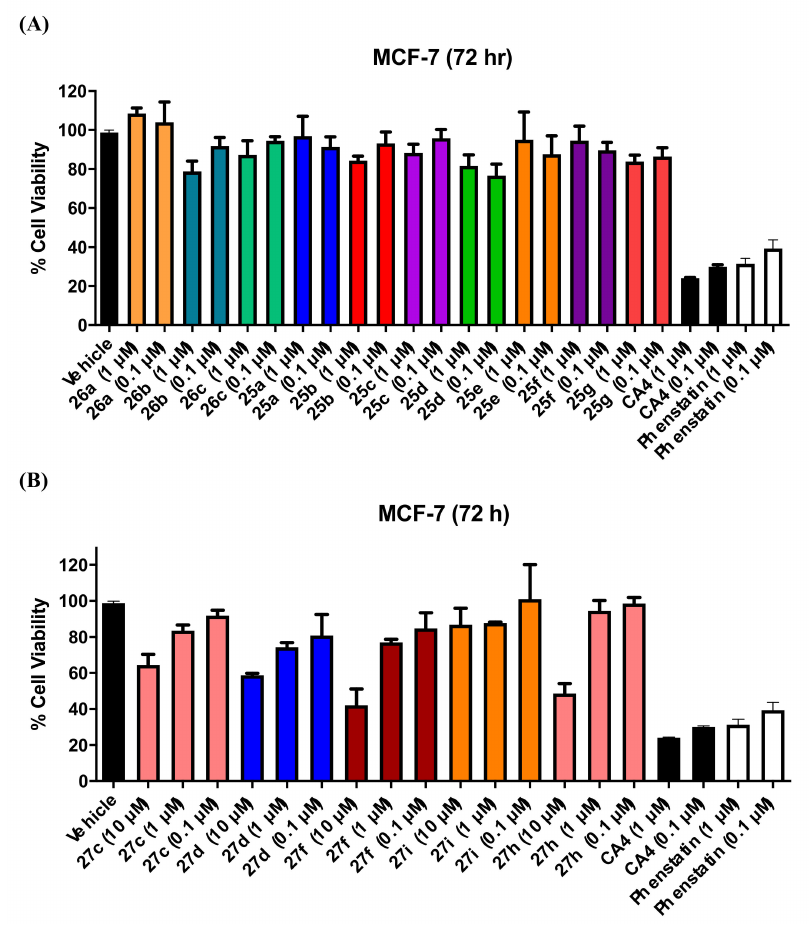
Figure 6. Preliminary cell viability data for ( A ) Series 5: 1-(diarylmethyl)pyrrolidines and 1- (diarylmethyl)piperidines 25a–g, 26a–c and ( B ) Series 5: 1-(diarylmethyl)piperazines 27c,d,f,i , and h in MCF-7 breast cancer cells. Cell proliferation of MCF-7 cells was determined with an alamarBlue assay (seeding density 2.5 × 10 4 cells/mL per well for 96-well plates). Compound concentrations of either 10, 1, or 0.1 µ M for 72 h were used to treat the cells (in triplicate) with control wells containing vehicle ethanol (1% v / v ). The mean value ± SEM for three independent experiments is shown. The positive controls used are CA-4 and phenstatin. Table 2. Antiproliferative effects of selected azole compounds 19e , 21l , and 24 in MCF-7, MDA-MB- 231 human breast cancer cells, and HL-60 leukaemia cell